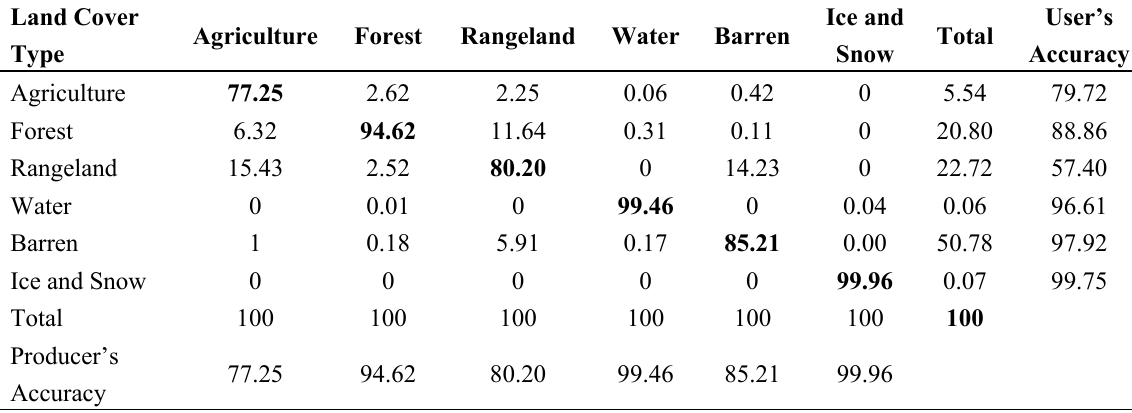
Table 4. Contingency table of derived 2009 LULC map.